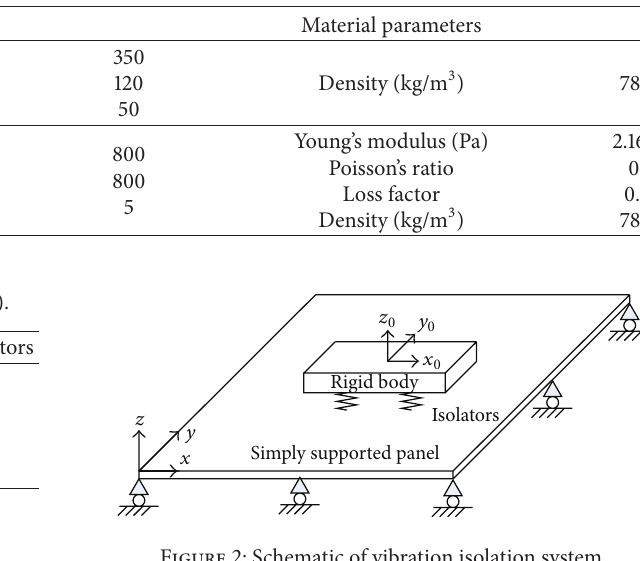
Table 3: Locations of response points (mm). Rigid body